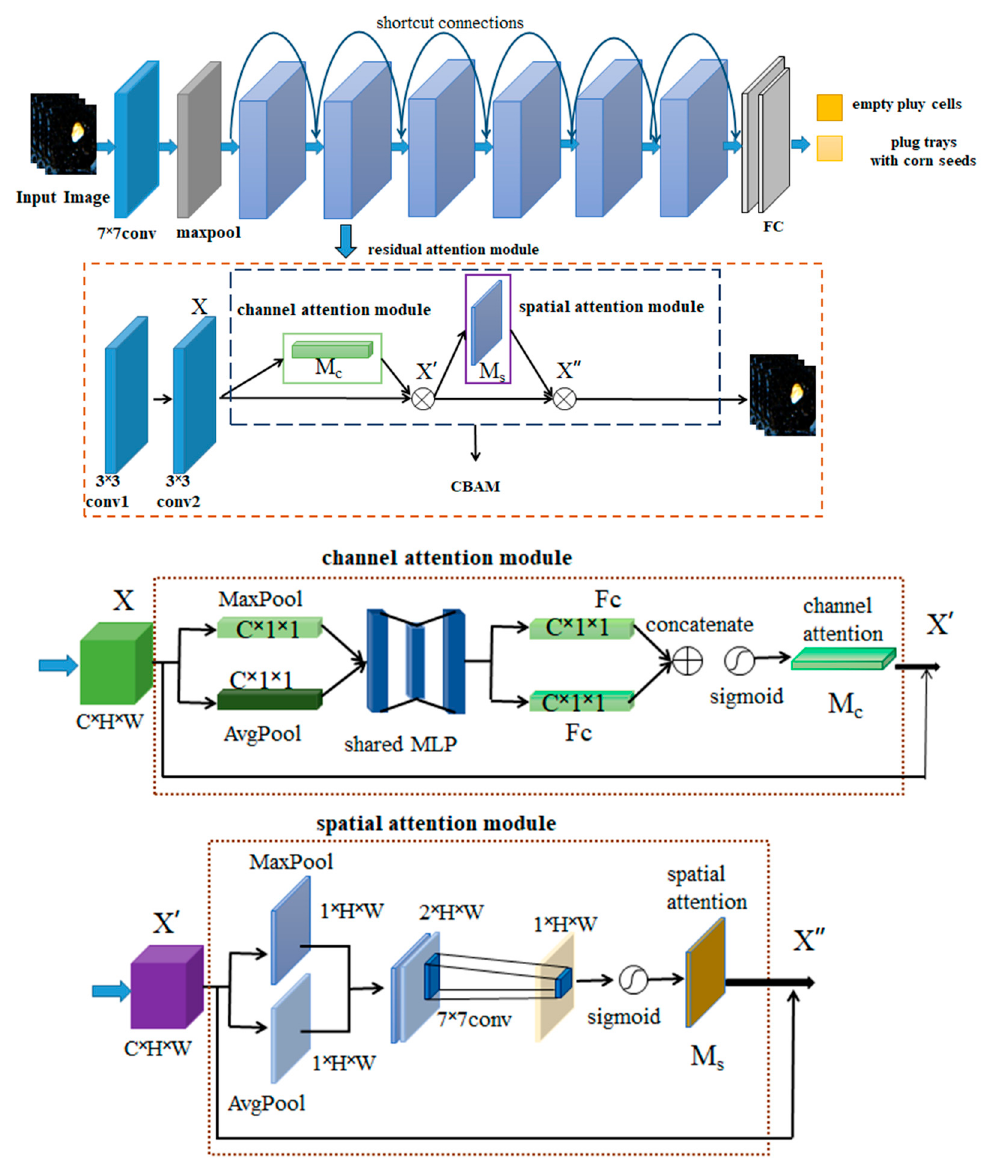
Figure 6. The network structure of CBAM-ResNet45 model.